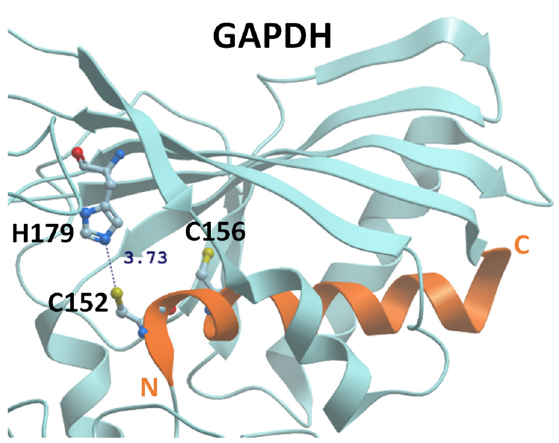
Figure 1. Electrostatic microenvironment lowers cysteine thiol pK a and stabilizes thiolate anion in human GAPDH (PDB: 6yne).